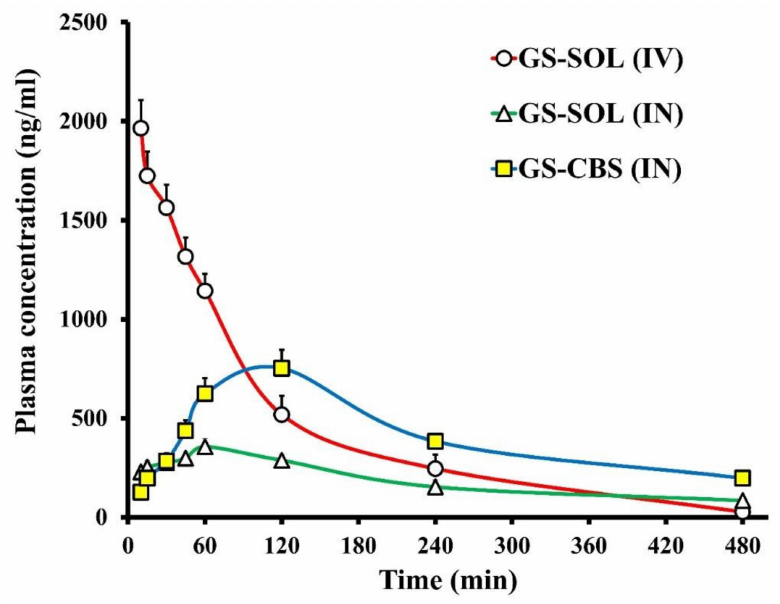
Figure 10. Granisetron levels in rat plasma following GS-SOL (IV), GS-SOL (IN) and GS-CBS (IN)